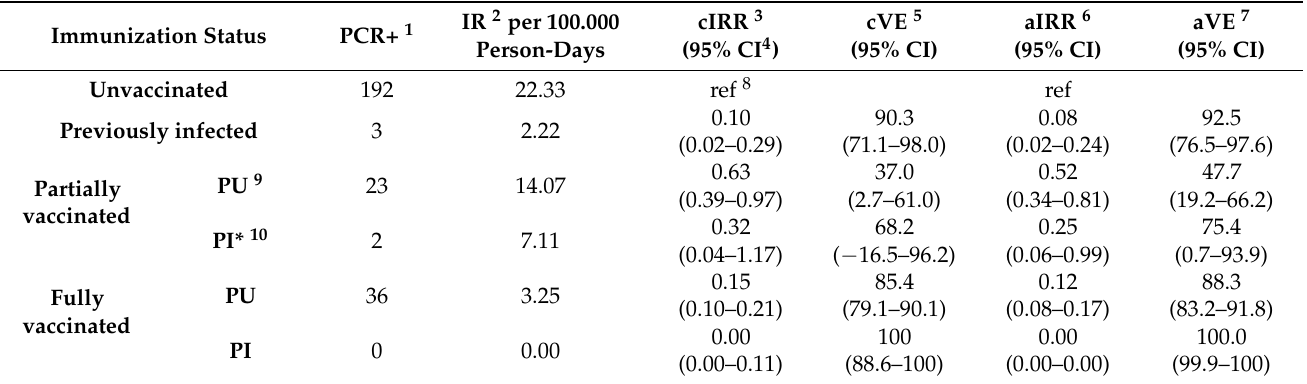
Table 2. Incidence rate ratios and vaccine effectiveness in any SARS-CoV-2 infection (participants with more than 14 days of